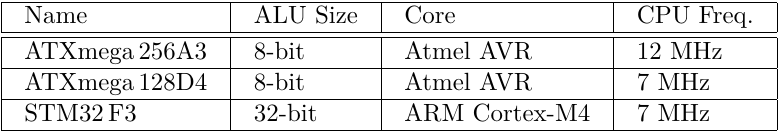
Table 3: Target microcontrollers of our attack